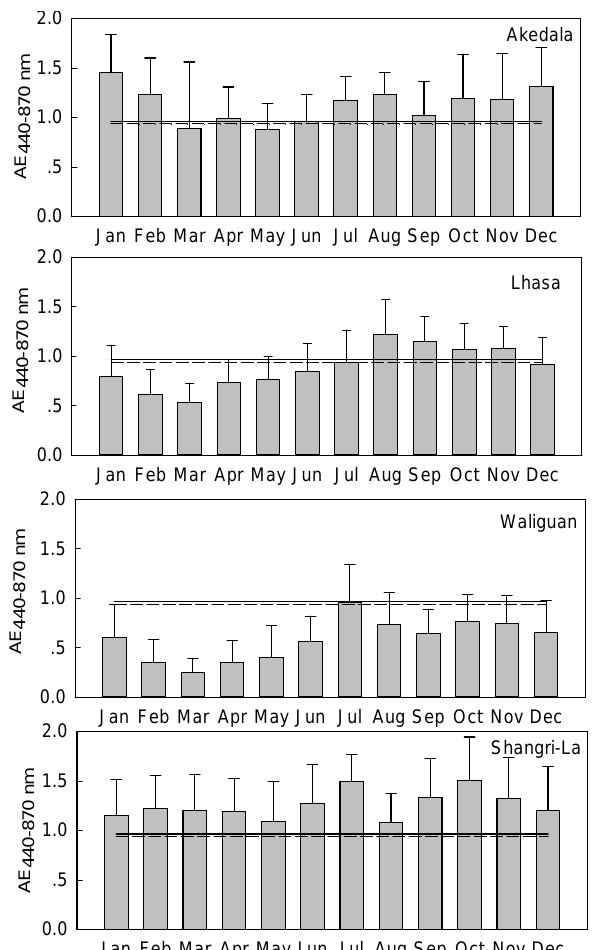
Figure 6. Monthly averaged AODs at 440nm at remote sites. The solid and dash horizontal hairlines indicate the annual averages for the subgroup and the whole database, respectively.